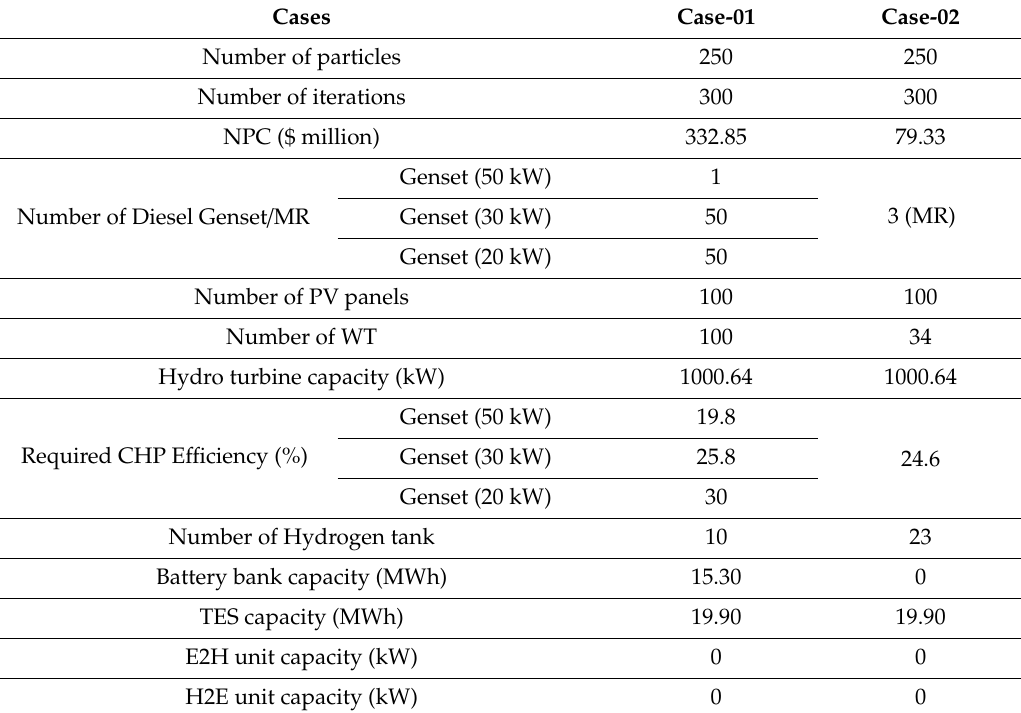
Table 3. Optimal system configuration of Case-01 and